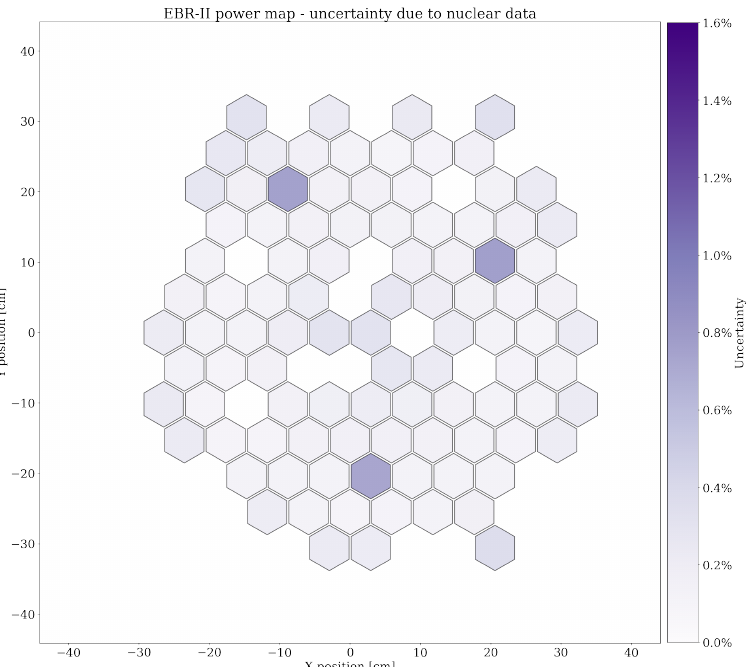
Figure 13. Sampler/KENO-MG uncertainty of axially integrated assembly powers using ENDF/B-VIII.0 data: whole core ( top ) and inner driver core ( bottom ). Note the different ranges of the color map for the two images.